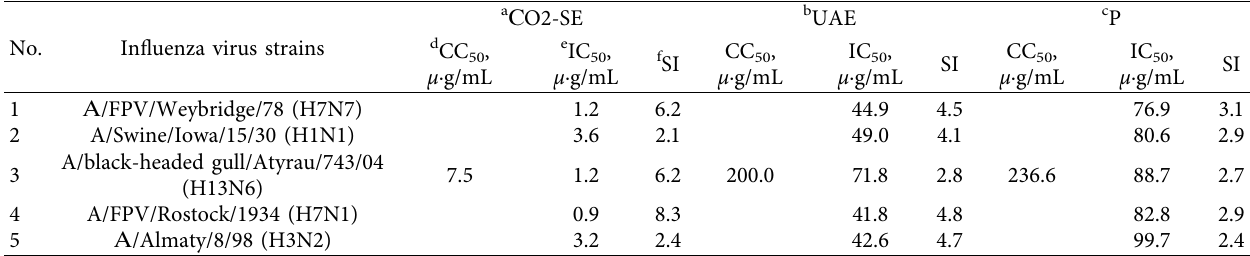
Table 3: Therapeutic activity of O. gmelinii root extracts on influenza viruses A.